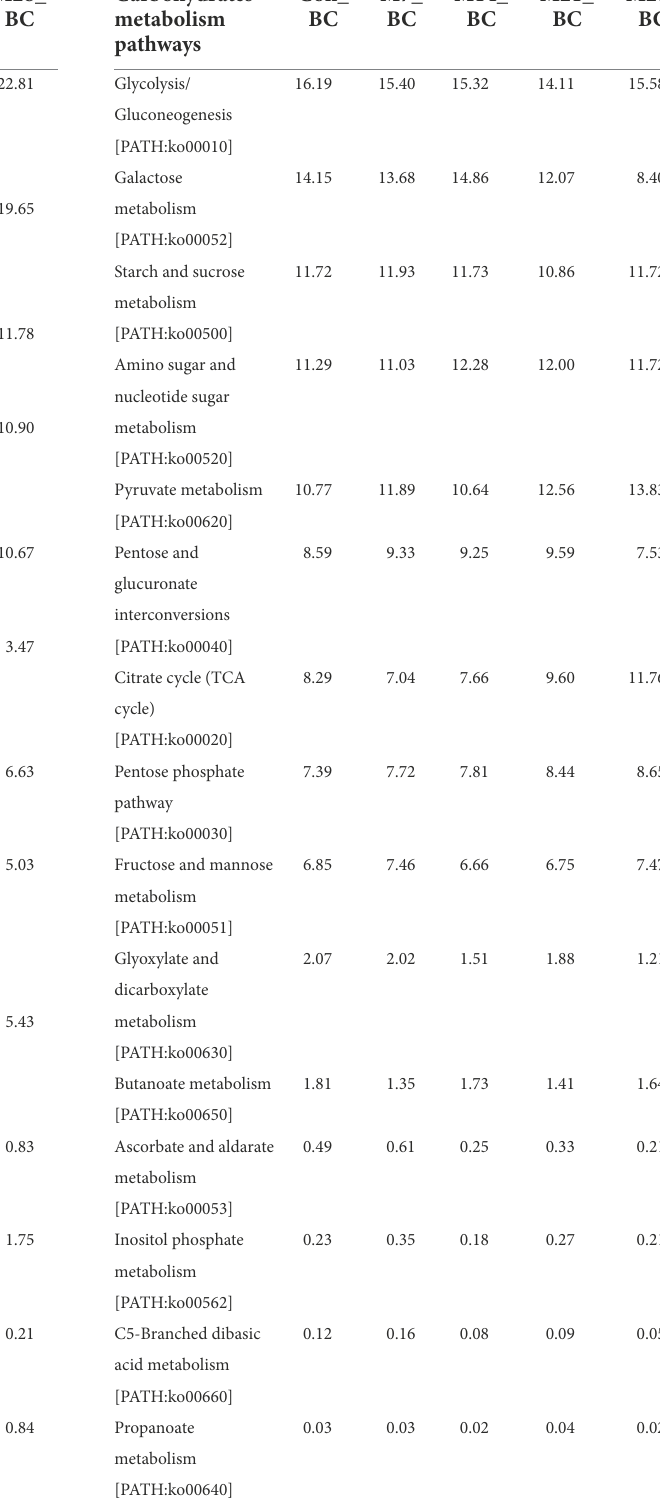
TABLE 5 Relative abundance (%) of the sequences linked to amino acids metabolism of pathways (KO level_3) in the caecum digesta samples from broiler chickens fed with diets containing different levels of marama bean meal.